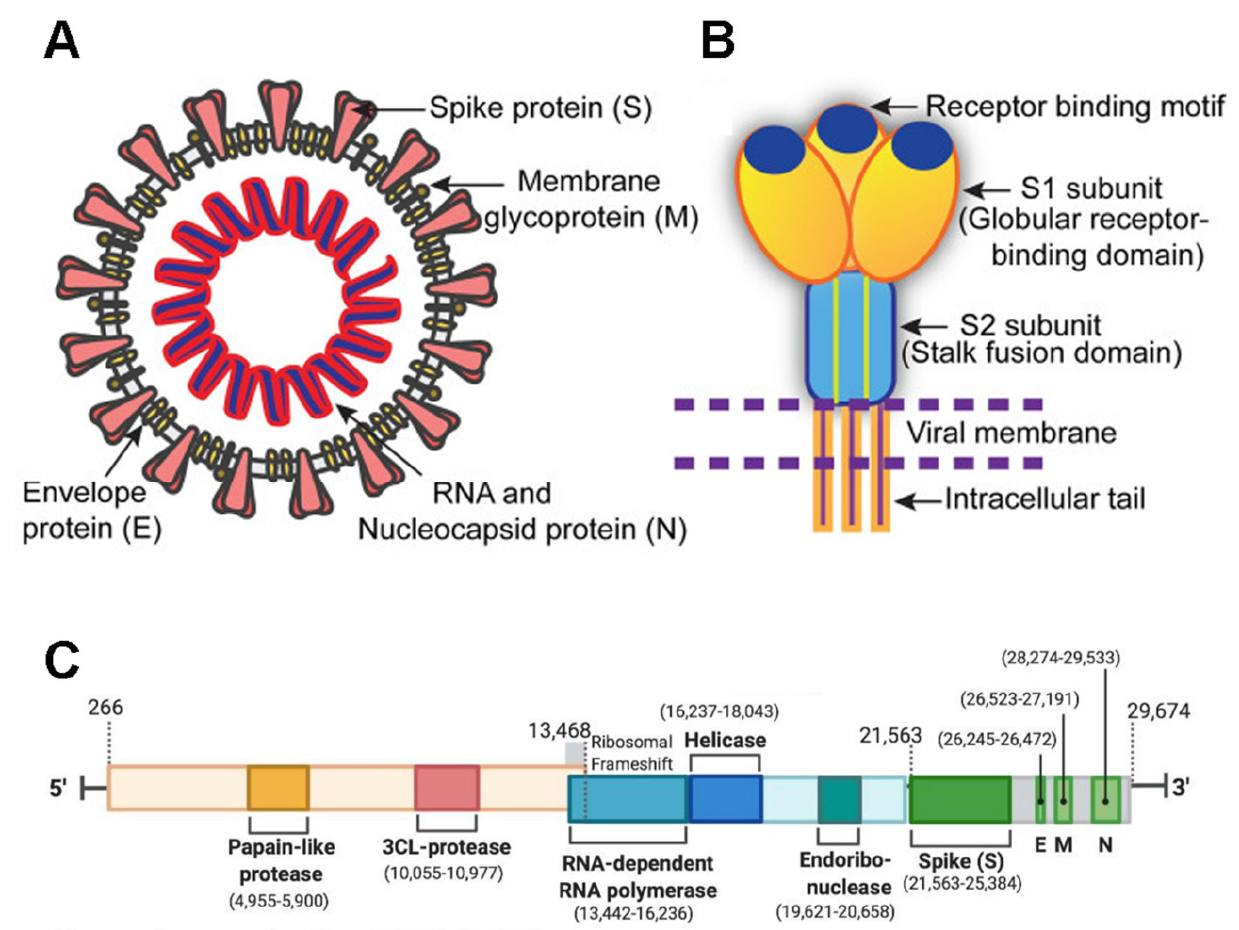
Figure 1. Structure of SARS-CoV-2. ( A ) The virus with the spike (S), envelope (E), membrane (M), and nucleocapsid (N) proteins are displayed. ( B ) The ACE-2 receptor. ( C ) Genomic organization. The orange-brown and the blue-green sections correspond to ORF1a and ORF1b, respectively. The illustrations are adapted from [2,3].